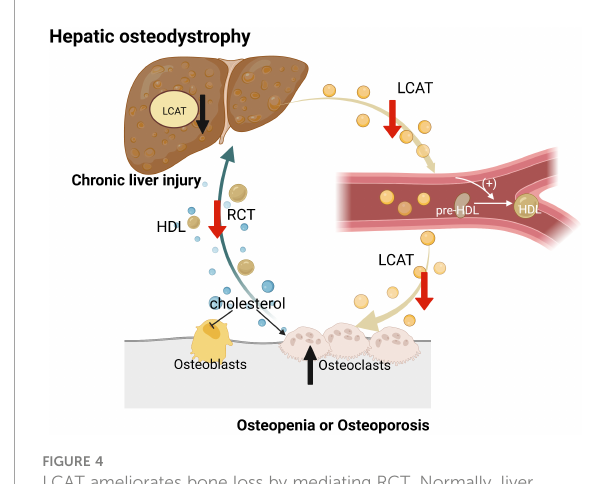
FIGURE 4 LCAT ameliorates bone loss by mediating RCT. Normally, liver secretes LCAT, which converts cholesterol obtained as HDL from surrounding tissues into cholesterol esters that are transported to liver for further metabolism. However, in the context of CLD, liver secretion of LCAT is blocked, resulting in restriction of RCT and accumulation of cholesterol in the bone that promotes osteoclast formation and inhibits osteoblast